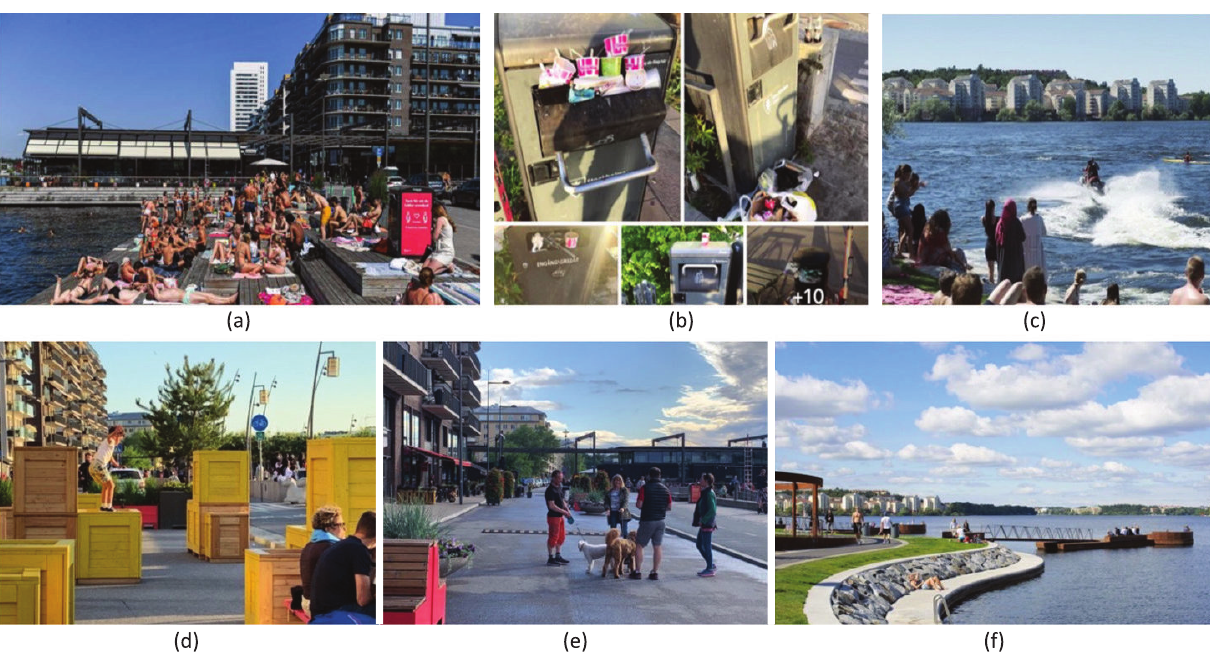
Figure 4. A snapshot of HBS during summer: (a) (Sun)bathing, (b) overloaded recycling bins, (c) jet ski on the water, (d) the parklet in the street, (e) people having conversations in the street, and (f) the eastern part of the waterfront park. Sources: (a) Kadhammar (2020), (b) Zimmerman (2020), (c) Sällström (2019), (d) and (e) author’s photos, and (f) Lindman and Johansson